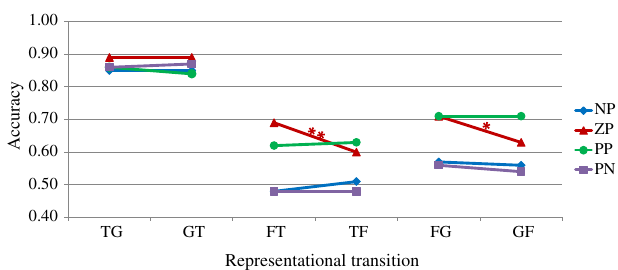
FIG. 3. Data from the 2-way interaction effect of representa- tional transition (TG, GT, FT, TF, FG and GF) and function type (NP, ZP, PP and PN). The data points connected by lines represent the pairs of transitions which are each other ’ s opposite. The p value of the comparisons is indicated by * for p < 0 . 05 , ** for p < 0 . 01 , *** for p < 0 . 001 . There are two significant asym- metries for ZP function type. The first between FT and TF transition with p < 0 . 01 , and the second between FG and GF transitions with p < 0 . 05